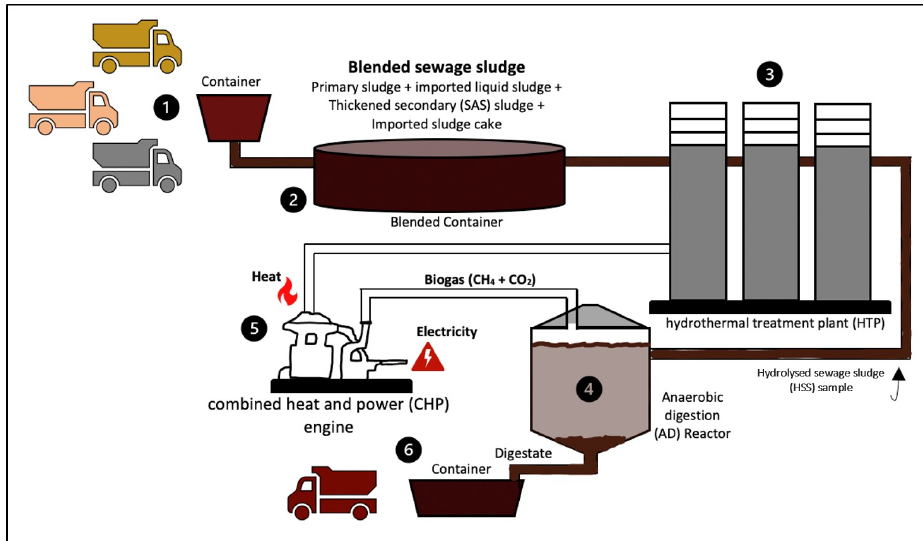
Figure 2. Sewage sludge processing at Esholt wastewater plant, Bradford, UK.